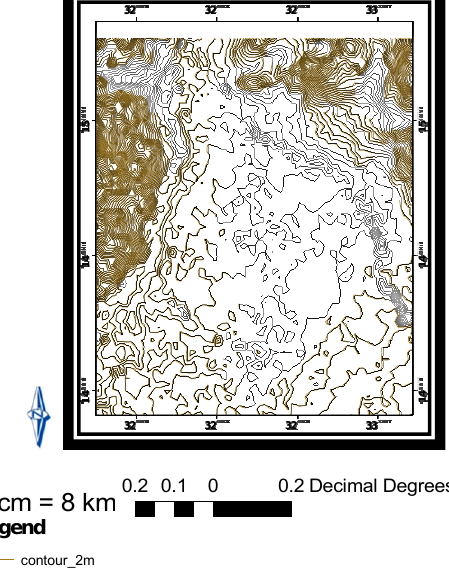
Fig (1) Khartoum Contour map of the study area was produced from the SRTM-DEM Using the Geo- Special analysis hydro terrain extension link with ArcGis10.2